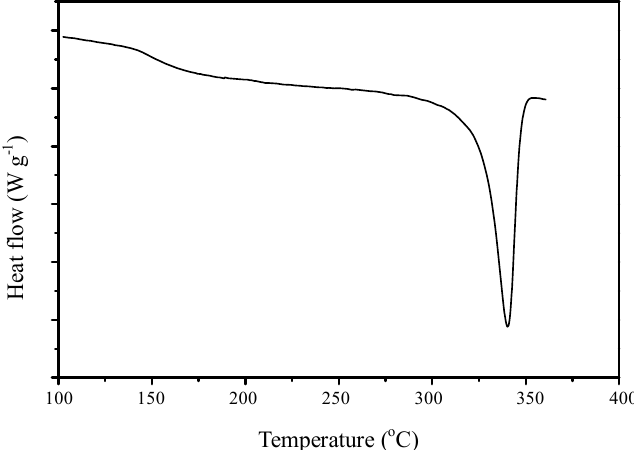
Figure 7. Typical differential scanning calorimetry (DSC) curve for the original PEEK. T m was 340°C, and the T g onset started at about 145°C.